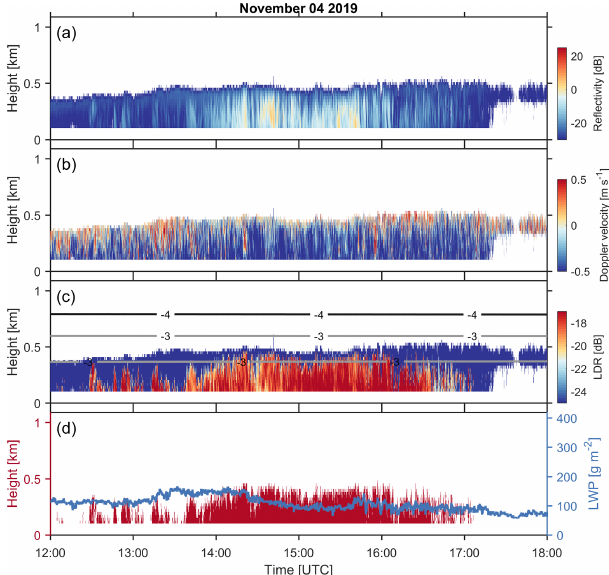
Figure 7. The columnar-ice-producing event on 4 November 2019. HYDRA-W observations of (a) equivalent reflectivity factor, (b) mean Doppler velocity, where negative velocity indicates down- ward motion, and (c) LDR. Panel (d) presents the (left axis) detected columnar-ice region and (right axis) LWP observed by HYDRA-W. The lines in (c) are isotherms produced by